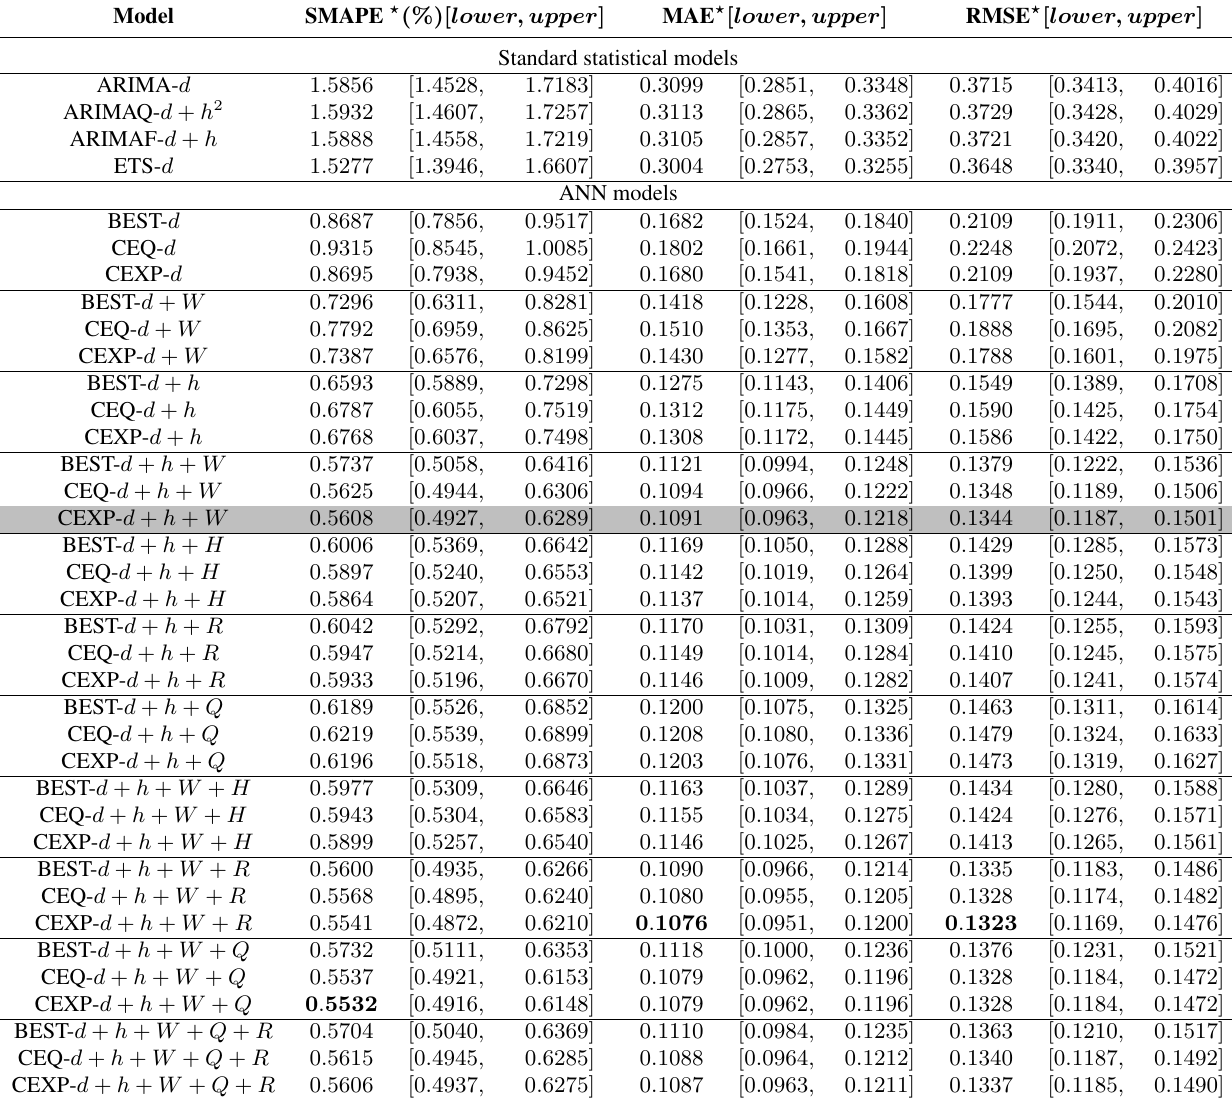
Table 3. Symmetric mean absolute percentage of error (SMAPE) (cid:63) , MAE (cid:63) and root mean square error (RMSE) (cid:63) results on the validation partition comparing different models, input features and combination schemes with the 99% confidence interval. BEST refers to the best past size ANN, CEQ refers to COMB-EQ ANNs, and CEXP refers to COMB-EXP ANNs. Bolded face numbers are the best results, and the gray marked row is the most significant combination of covariates. ARIMA: auto-regressive integrated moving average models; ARIMAQ: ARIMA with covariate x = h as a quadratic form (ARIMAQ); ARIMAF: ARIMA with covariate x = h as a